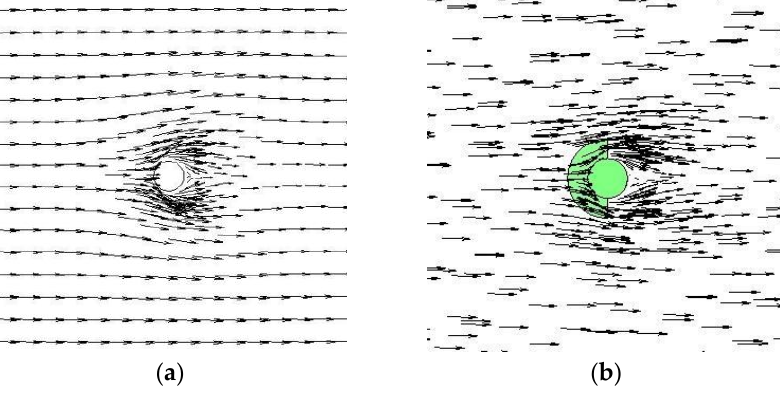
Figure 9. Velocity vectors at Z = 5 cm. ( a ) Single pier; ( b ) Pier with ring-wing plate; ( c ) Pier with combined device.